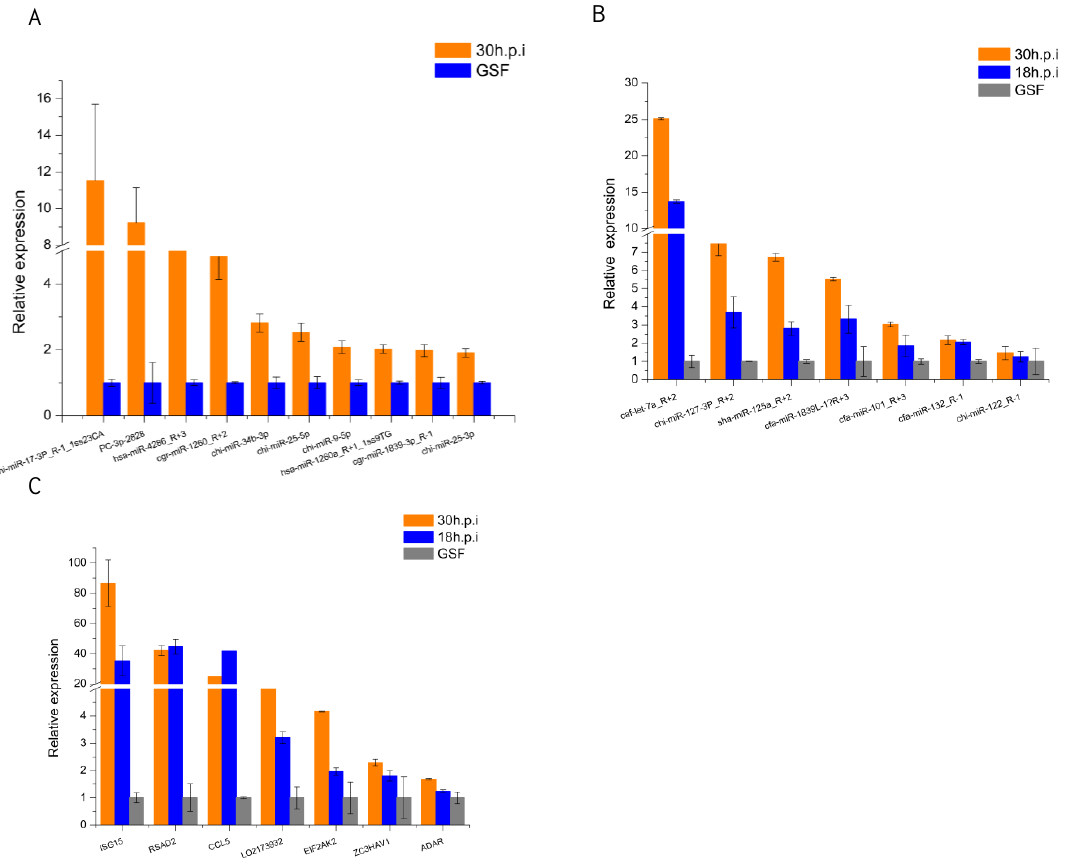
Figure 8. RT-qPCR validation of DE miRNAs and DEGs. ( A ) RT-qPCR validation of DE miRNAs in Figure 8 . RT-qPCR validation of DE miRNAs and DEGs 30h.p.i vs. GSF. ( B ) RT-qPCR validation of DE miRNAs in both 18h.p.i vs. GSF and 30h.p.i vs. GSF. ( C ) RT-qPCR validation of